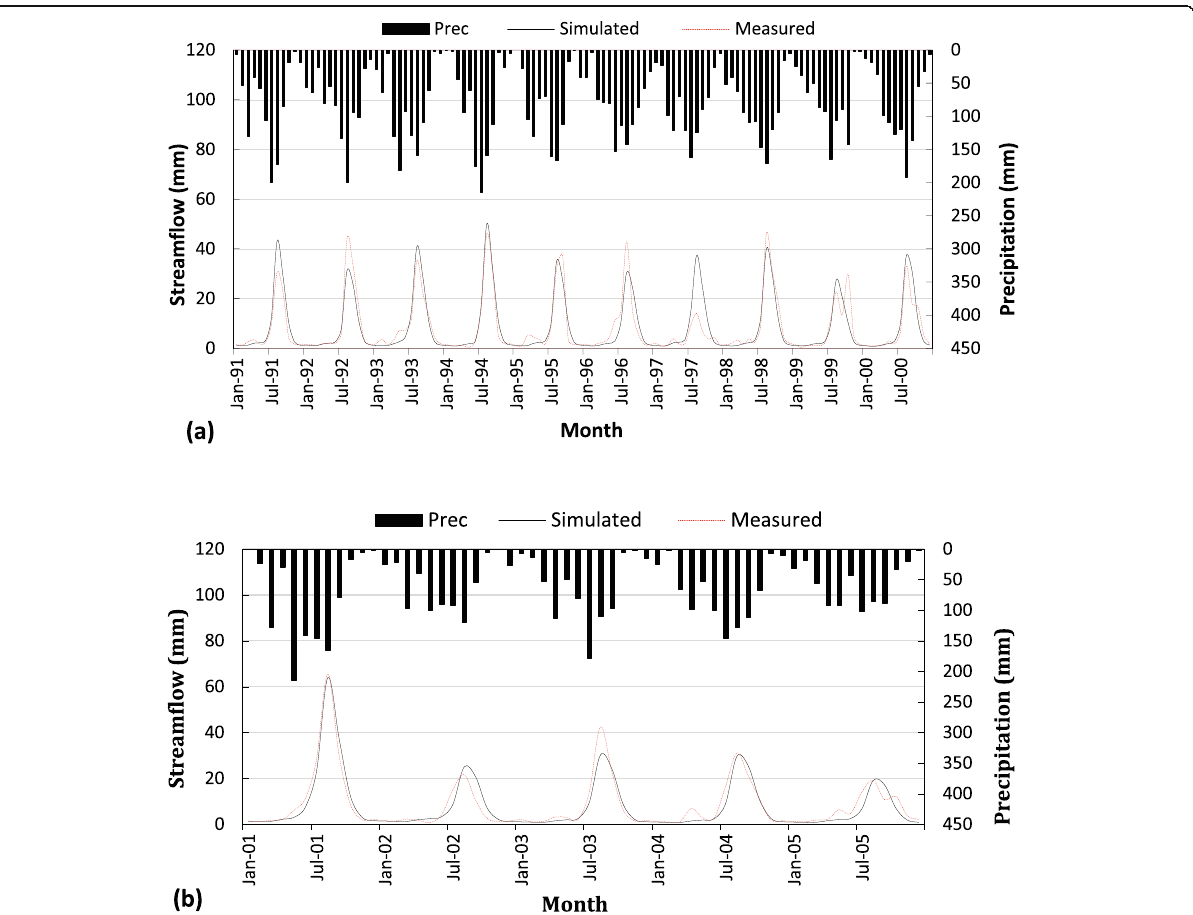
Fig. 6 Monthly hydrograph of measured and simulated streamflow of the Ketar River at Abura gauging station and monthly precipitation of the subbasin: a the calibration period and b the validation